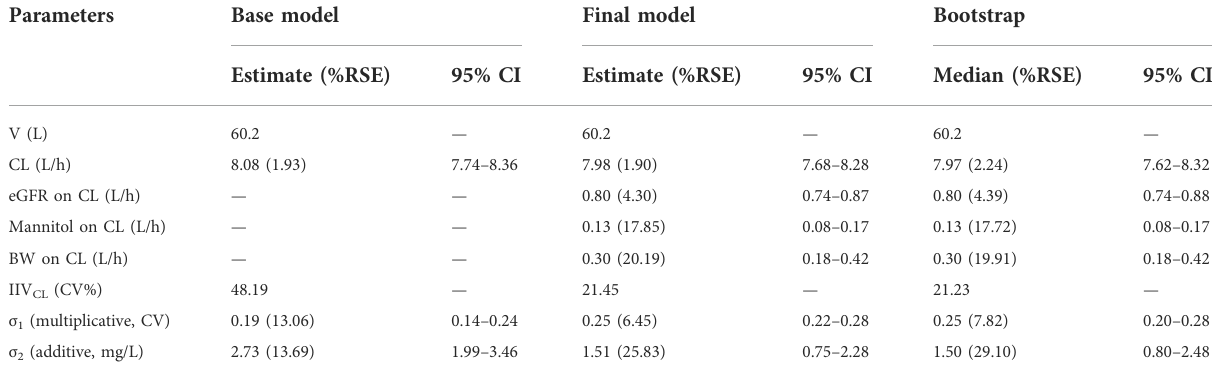
TABLE 3 Parameter estimates and Bootstrap results of vancomycin population pharmacokinetic